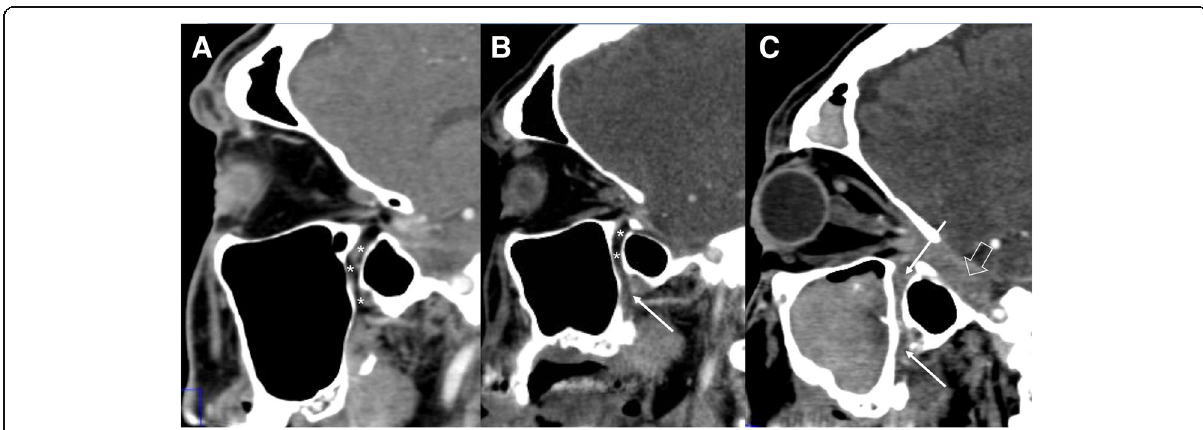
Fig. 19 Perineural spread of tumor. Patient with squamous carcinoma of the retromolar trigone. CT sagittal images at 0 ( a ), 6 ( b ), and 12 ( c ) months follow-up. Note the progressive infiltration (arrows) of the pterygopalatine fossa (asterisks) with obliteration of the normal fatty tissue. In ( c ), it is evident the invasion of Meckel ’ s cave (empty